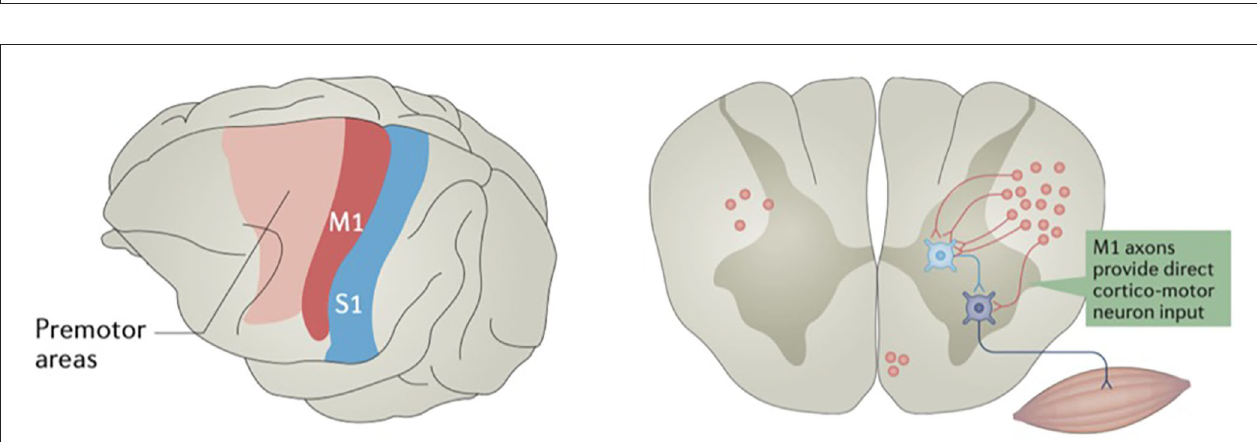
FIGURE 2 | Some motor cortex neurons terminate on spinal cord interneurons, while others terminate directly on motor neurons. The primary motor cortex (M1) is in red, and primary somatosensory cortex (S1) is in blue. Reprinted by permission from Springer Nature Customer Service Centre GmbH: Springer Nature, Nature Reviews: Neuroscience, Motor cortex—to act or not to act? Christian Laut Ebbesen, et al., 2017.